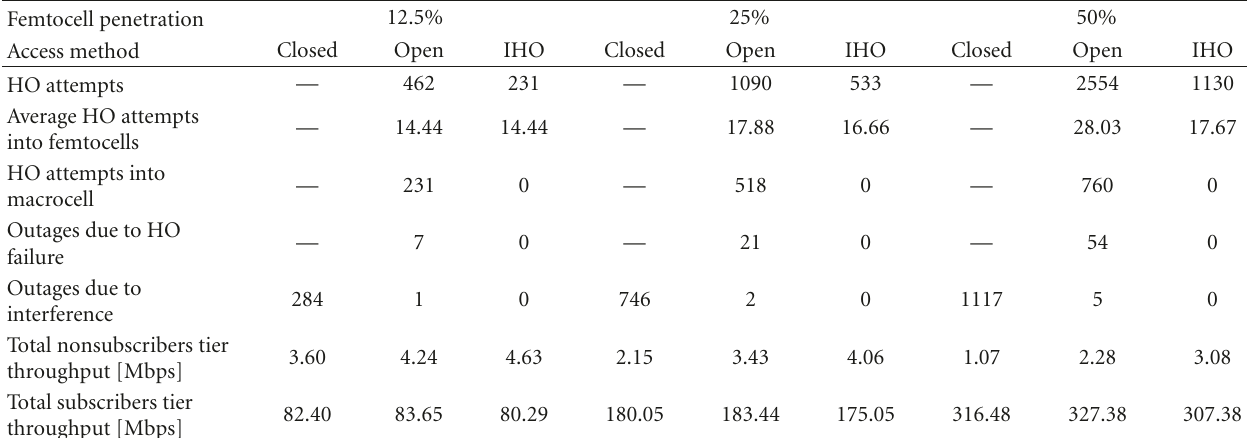
Table 8: Performance comparison for Setup 3 (800 s simulation).